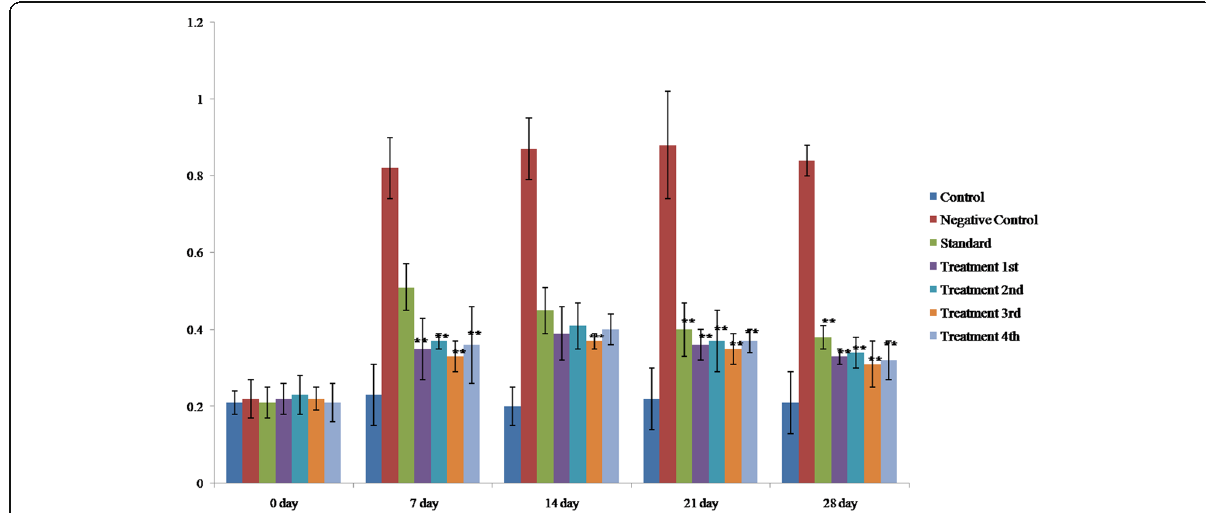
Fig. 4 Effect of PH extracts on mean change in paw volume. Values are Mean ± S.E.M, n = 6 animals in each group. Results are Mean ± S.E.M. ANOVA, Dunnett ’ s test *** p < 0.001, ** p < 0.01 (treated groups Vs arthritic control group